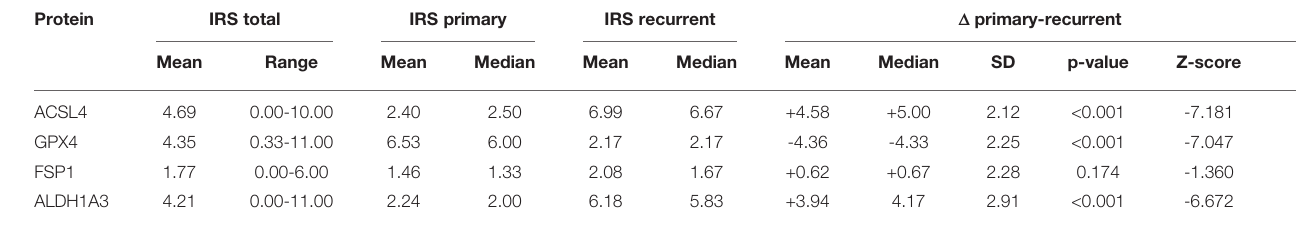
TABLE 3 | Summary of results of immunohistochemistry.